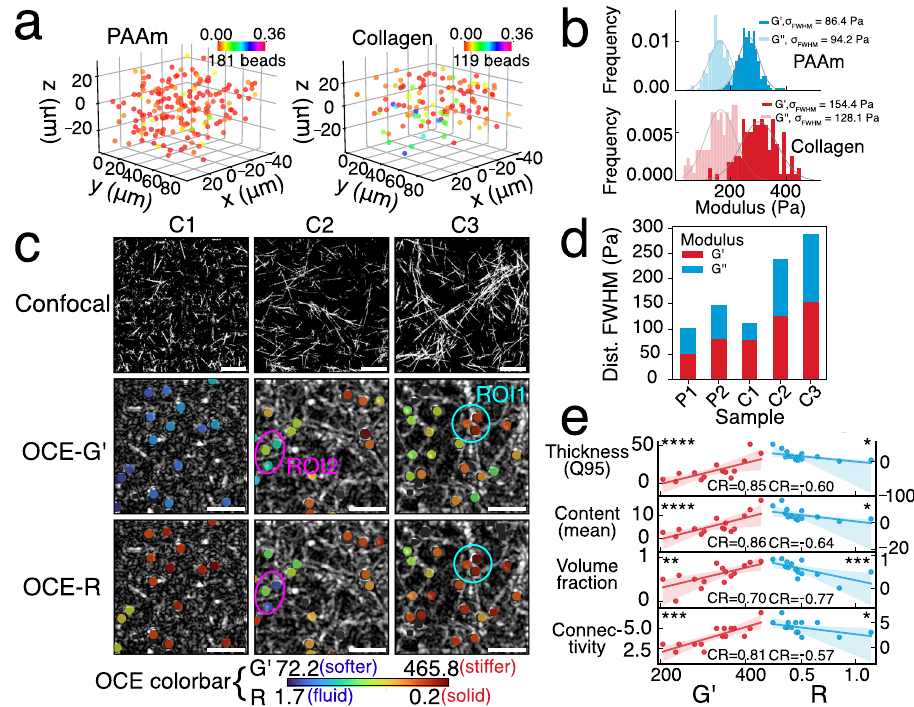
Fig. 2 Characterisation of micromechanical heterogeneity in fi brous collagen matrices. a Normalised relative variation in stiffness (de fi ned as [( G ′ – G ′ median ) / G ′ median ] 2 ) measured by 3D LS-pfOCE in a PAAm gel (3T2C, left) and collagen matrix (C3, right), where larger variation is observed in collagen. N = 181 and 119 beads for PAAm and collagen, respectively. b Histograms and statistical distributions of absolute (i.e., without normalisation) G ′ and G ″ measurements in a . σ FWHM indicates the FWHM of the distributions. En face confocal re fl ectance microscopy (top, FOV 106 µ m × 106 µ m) and resolution-enhanced OCT images (following procedure in ref. 68 ) overlaid with colour-coded LS-pfOCE measurements of G ′ (middle) and R (bottom) at the focal plane. Confocal images serve as higher- resolution references for visualising the microstructures of each collagen sample and are not co-registered with OCE images. ROI1 (cyan circles) indicates a stiffer and more solid-like microenvironment in the presence of thick collagen fi bres. ROI2 indicates a more compliant and fl uid-like microenvironment in the absence of any clear collagen fi bres. All OCE images show a FOV of 71 µ m × 71 µ m. Scale bar, 20 μ m. d , FWHM of the distributions of LS-pfOCE G ′ (red) and G ′ (blue) in PAAm gels and collagen matrices. N = 137, 107, 105, 132 and 100 beads for P1 (3T1C), P2 (3T2C), C1, C2, and C3, respectively. e Correlation of LS-pfOCE G ′ (red) and R (blue) to measures of collagen matrix microarchitectural characteristics. N = 15 beads in sample C3. Q95 and Mean indicate the 0.95 quantile and mean of OCT scattering intensity within a 3- µ m radial distance from the circumference of each bead, respectively. Fibre volume fraction likewise represents fraction within the 3- µ m radius around each bead. Fibre connectivity represents the number connected fi bre branches at each “ node ” (i.e., bead) (see “ Methods ” for further details). CR indicates the Spearman rank correlation coef fi cient; signi fi cance of the correlation is indicated by * p value < 0.05, ** p value < 0.01, *** p value < 0.001 and **** p value < 0.0001. Solid line and shaded region represent the linear best- fi t line and 95% con fi dence interval,